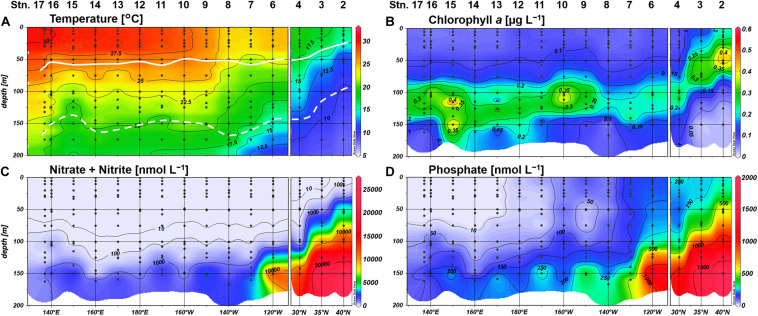
Distributions of (A) temperature, (B) chlorophyll a concentrations, (C) nitrate+nitrite concentrations, and (D) phosphate concentrations. Light depths of 10% and 0.1% are indicated by white bold and dashed lines, respectively.